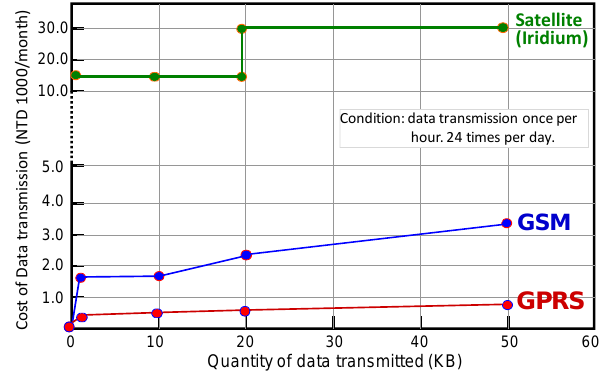
Figure 5 Comparison of various data transmission costs Fig. 5. Comparison of various data transmission